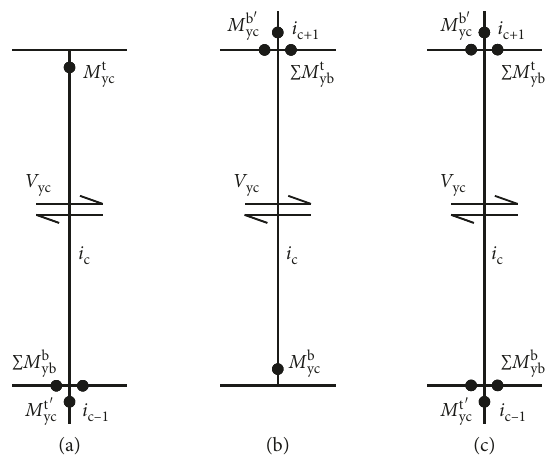
Figure 11: Method of plastic hinge at the column end: (a) top layer, (b) bottom layer, and (c) middle